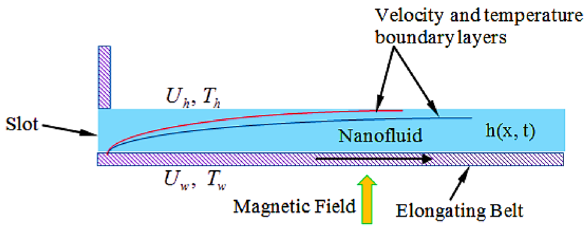
Figure 1. Geometry representation of the